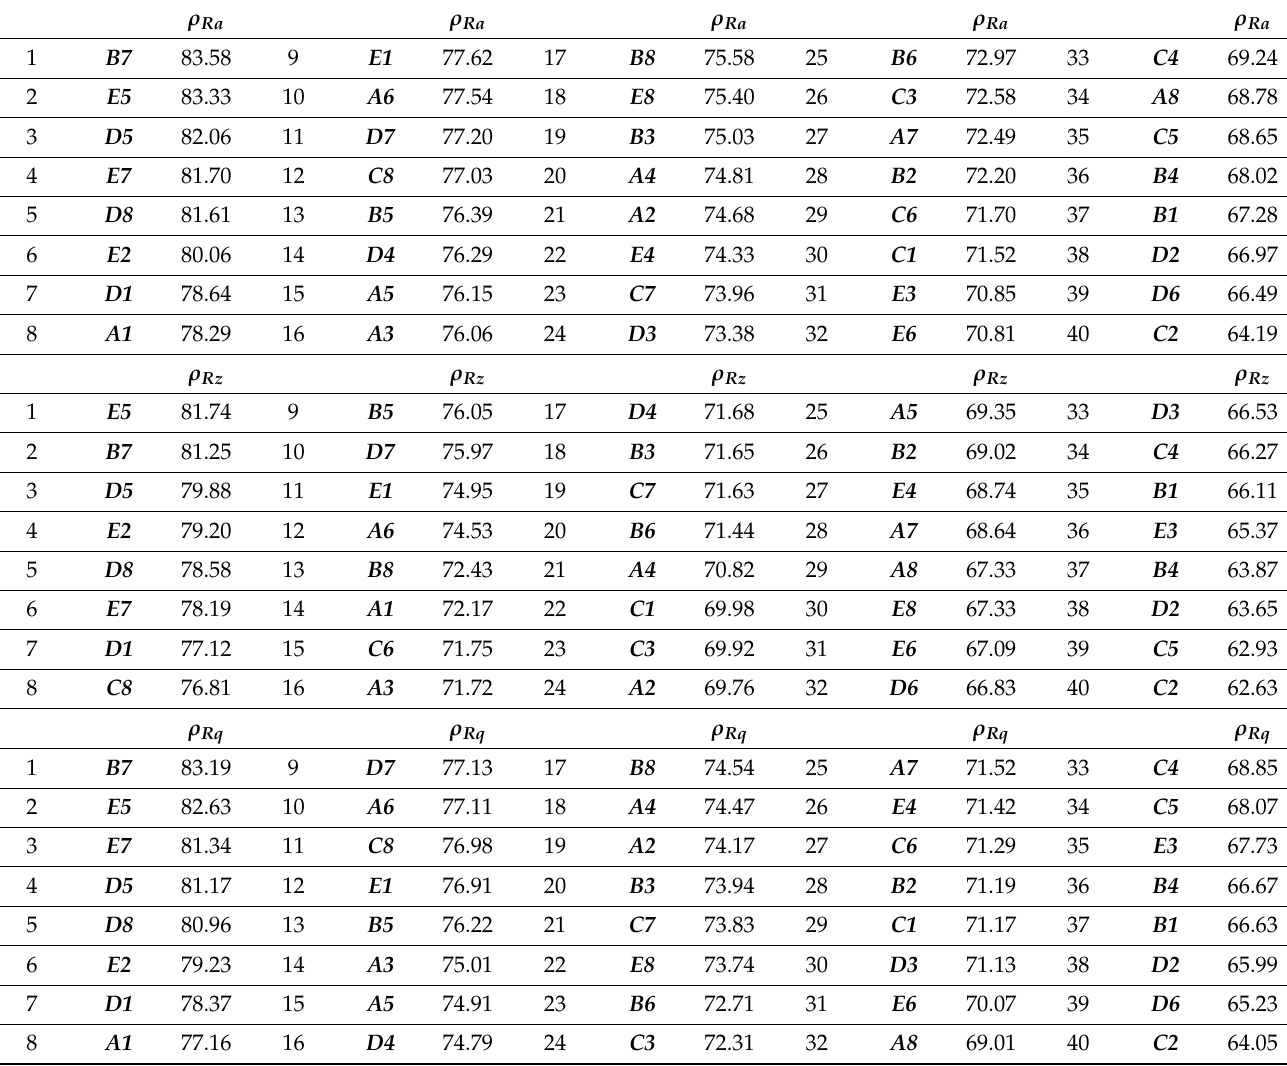
Table 5. The sequence formation based on improvement ratios for R a , R z , and R q .